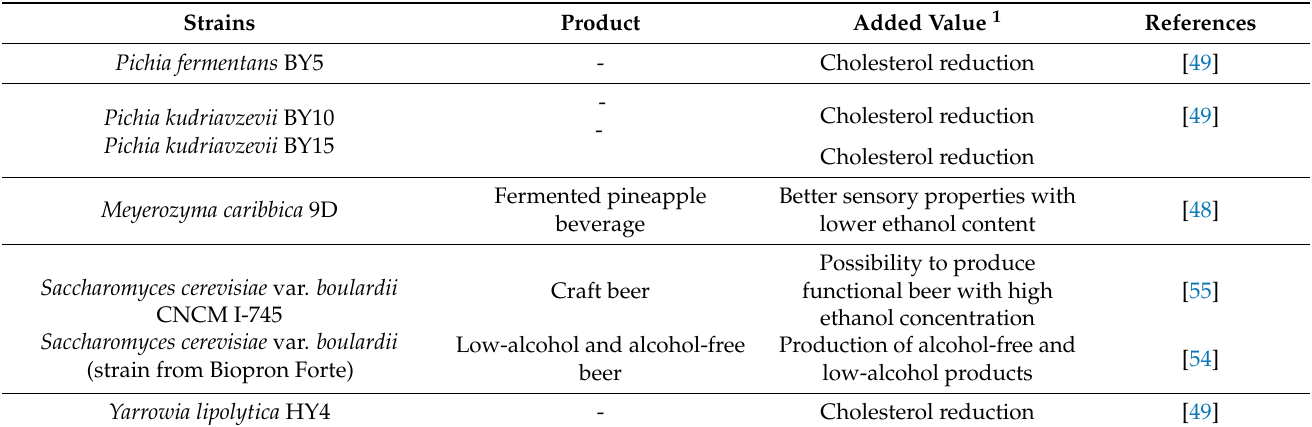
Table 4. Novel probiotic and potentially probiotic strains of yeast for potential application in